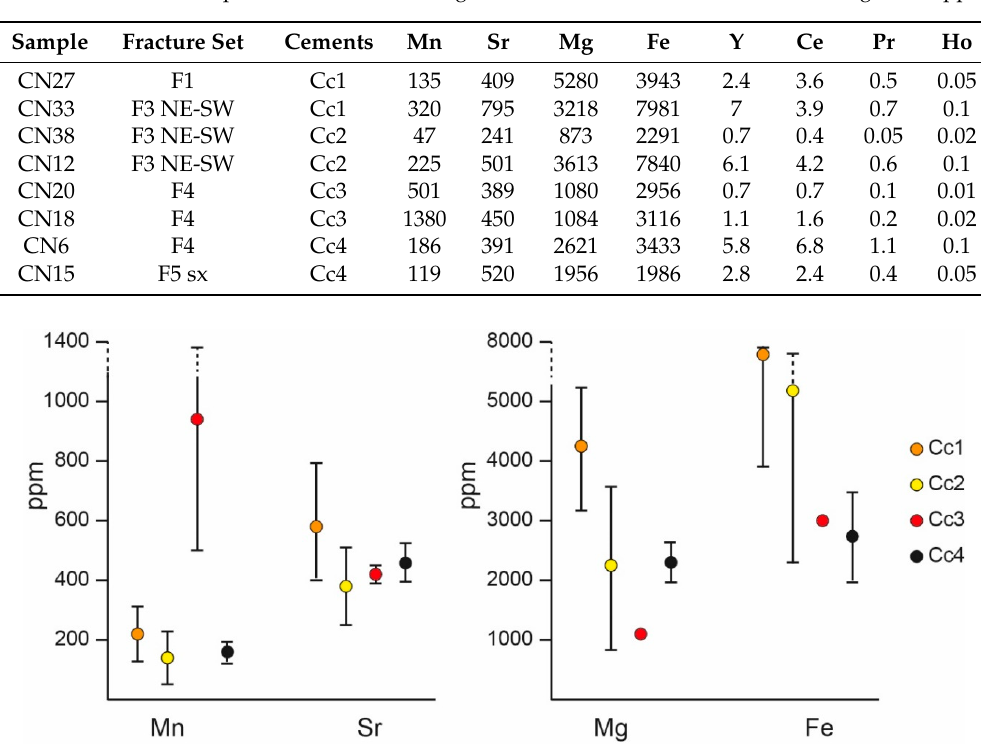
Figure 14. Elemental composition in parts per million (ppm) measured on the four generations of calcite cements. Bars indicate maximum, minimum and average composition of each cement.